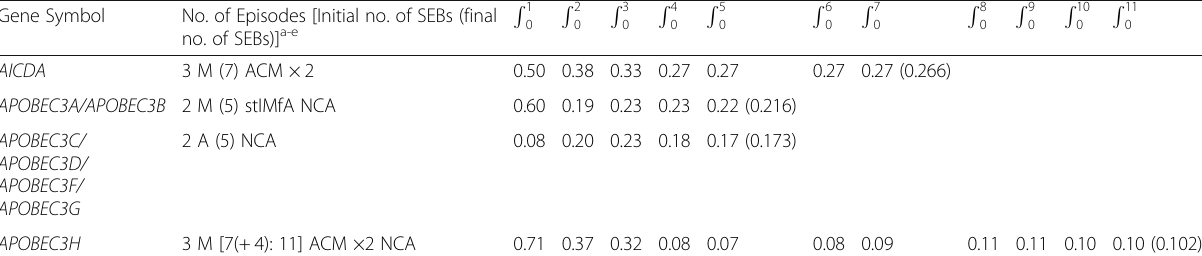
Table 14 Chromosome 12 ( − ) strand chromatin consensus sequence recognition (CSR) and somatic hypermutation (SHM) enzyme gene, AICDA , and chromosome 22 (+) strand CSR and SHM gene, APOBEC3A through APOBEC3H , sequential esebssiwaagoT Q s to final 2-digit (and 3-Q digit) esebssiwaagoT Q